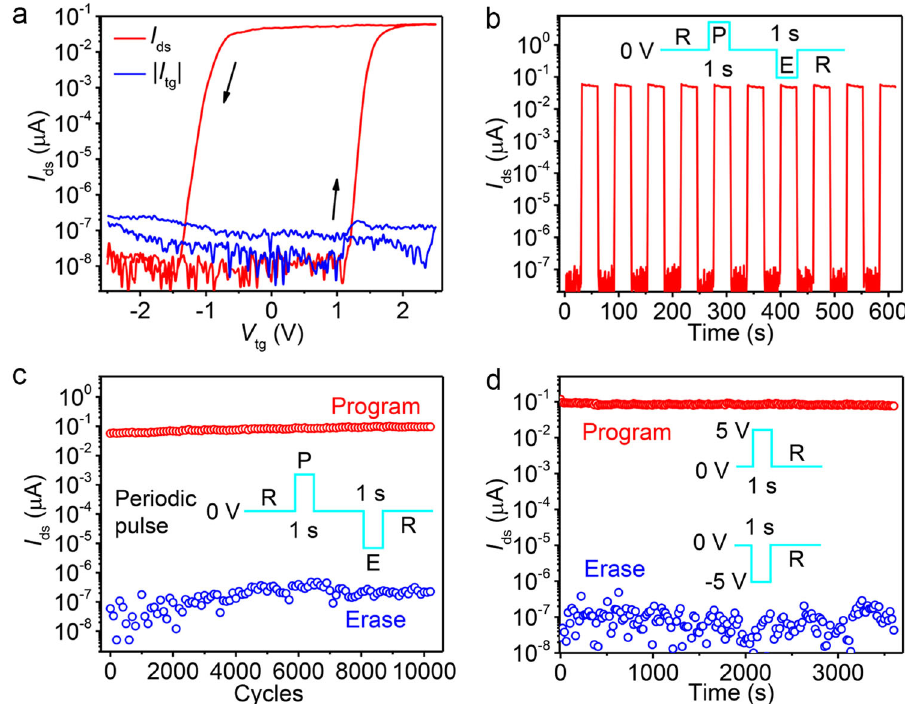
Fig. 3 Cycle endurance and time retention characteristics. a Top-gate I ds − V tg characteristics (red) and leakage current (black) of a vdW FeFET measured with V ds = 0.5 V and internal gate fl oating. The device has a four-layer MoS 2 channel and an 86-nm-thick CIPS layer. b Dynamic characteristics of the same vdW FeFET in response to periodic top-gate voltage pulses with an amplitude of 3.5 V and width of 1 s. I ds was probed with V ds = 0.5 V after applying the gate pulse. Inset shows the periodic pulse mode applied to the top gate. c Endurance performance through more than 10 4 P/E cycles. d Retention properties of this device at the program and erase states. I ds was monitored at V ds = 0.5 V and V tg = 0